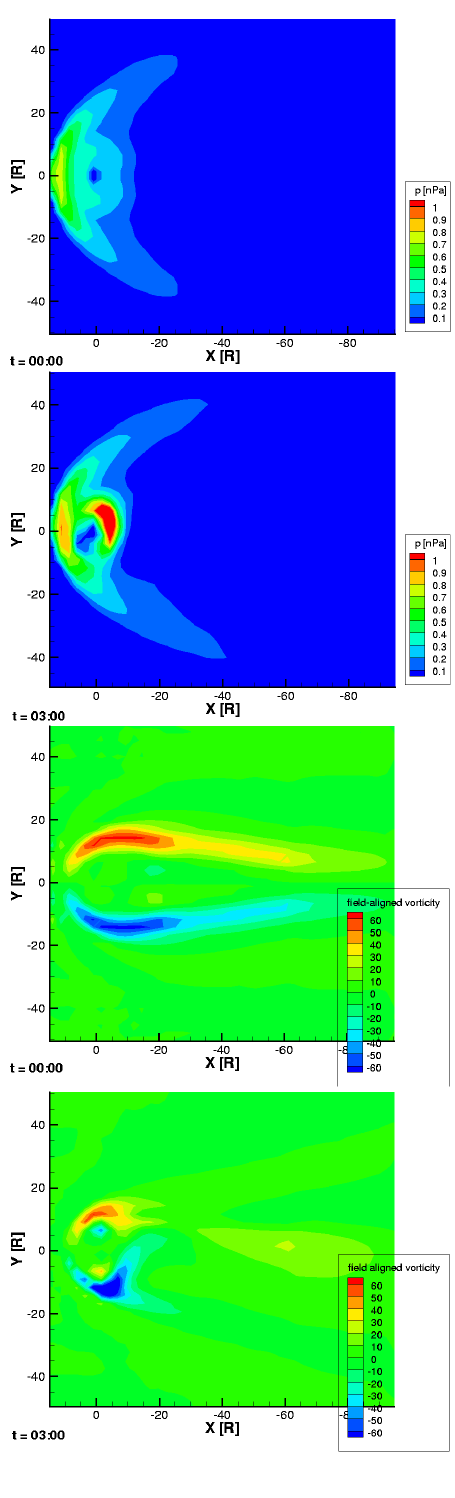
Fig. 9. Cross sectional panels in the Z=0 plane of the plasma pres- sure (upper panel) and field-aligned vorticity (bottom panel). The left is at 00:00UT and the right at